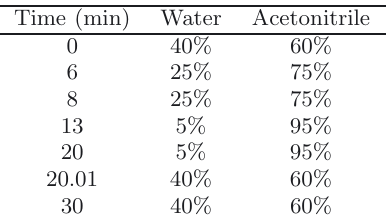
Table 1. Gradient of